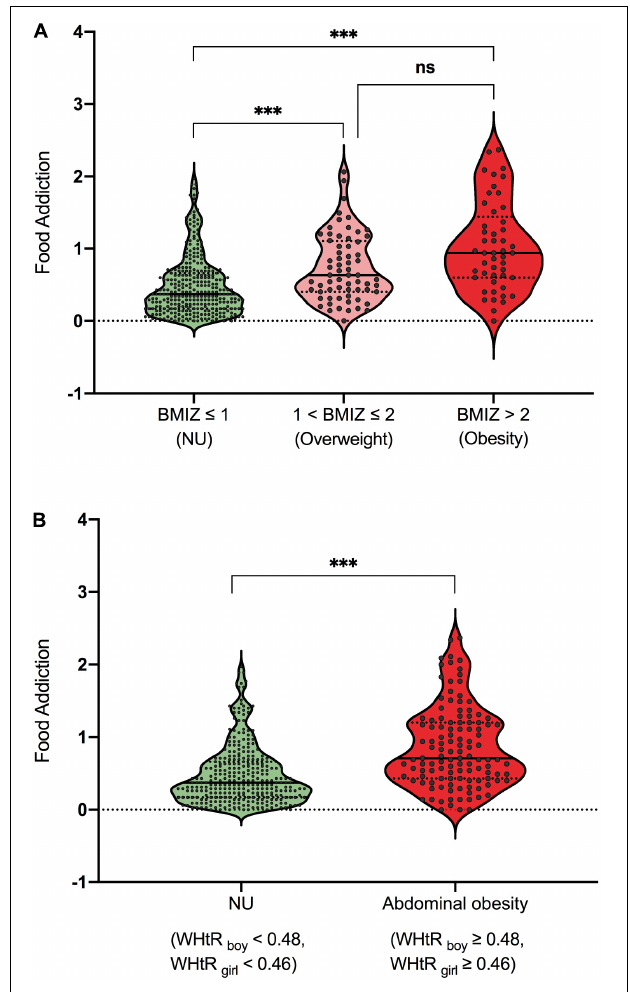
FIGURE 4 | (A,B) Differences of addictive-like eating behavior across subgroups. *** p < 0.001. ns, not significant.